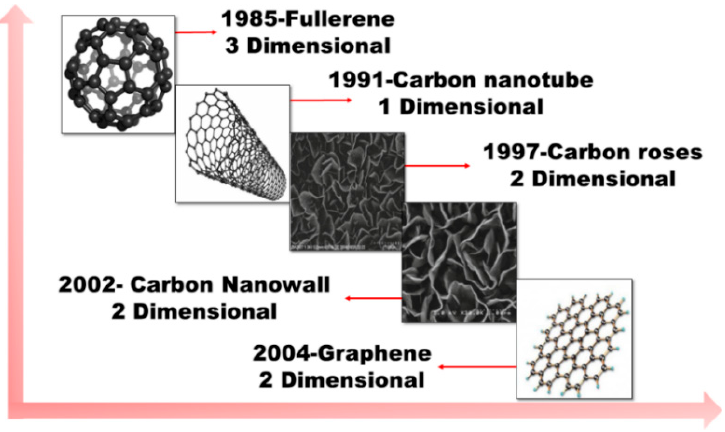
Figure 1. Milestones in carbon nanostructure research.